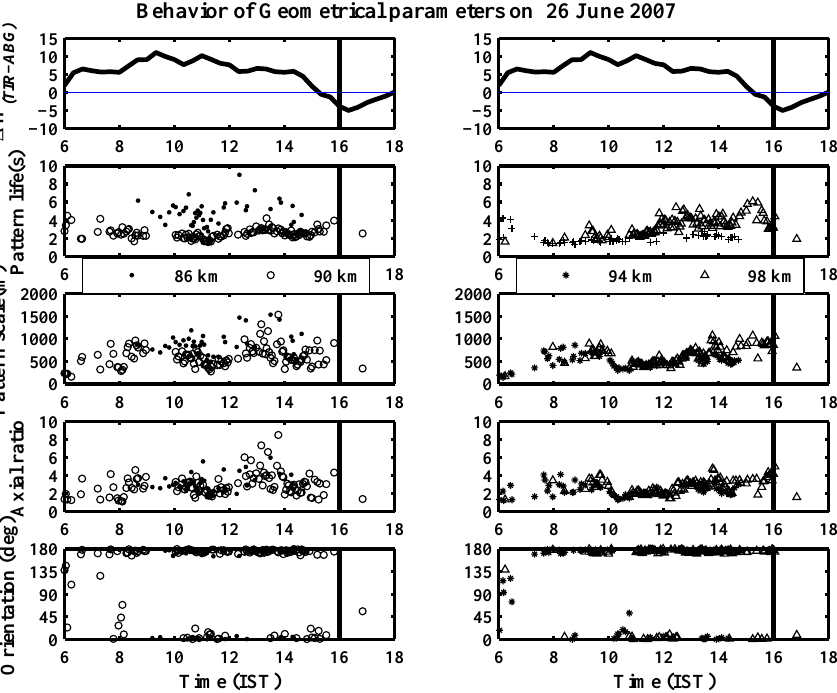
Fig. 2c. [ 1H TIR − 1H ABG ] (top panels) and temporal variation of various geometrical parameters for 86, 90, 94 and 98km (remaining panels) on 26 June 2007. See text for more details.